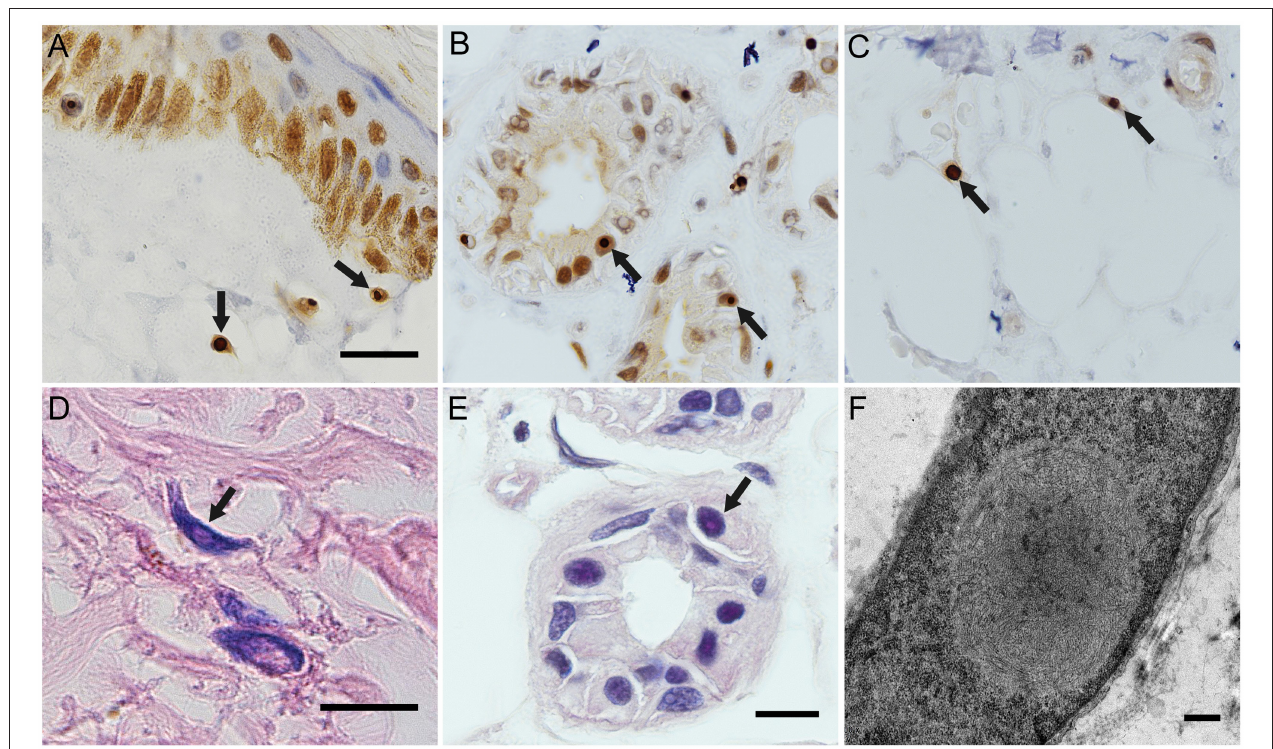
FIGURE 2 | Histopathological findings of NIID cases. Ubiquitin immunostaing inclusion bodies in the nuclei of the fibroblasts of subject 4 (A) , of the sweat gland cells of subject 5 (B) , and of the fat cells of subject 5 (C) . Eosinophilic intranuclear inclusion bodies in the fibroblasts of subject 2 (D) and in the sweat gland cells of subject 5 (E) . Intranuclear inclusion bodies in the fibroblasts of subject 5 under electron microscope (F) . Arrows indicated intranuclear inclusion bodies. Scale bars: (A–E) 10 µ m; (F)